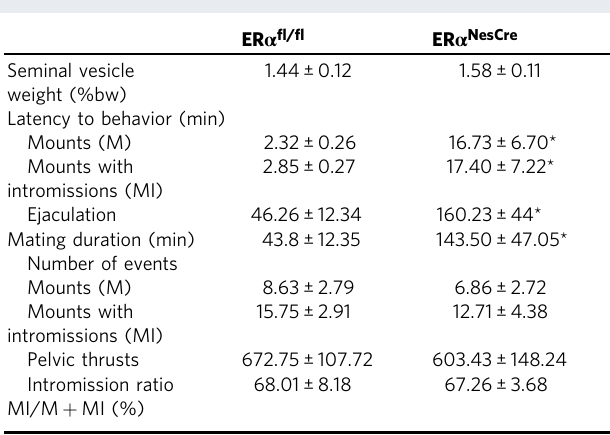
Table 2 Sexual behavior of castrated and testosterone supplemented ER α NesCre males.